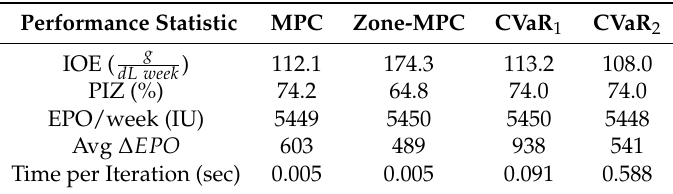
Table 2. Simulation results under Gaussian distribution.